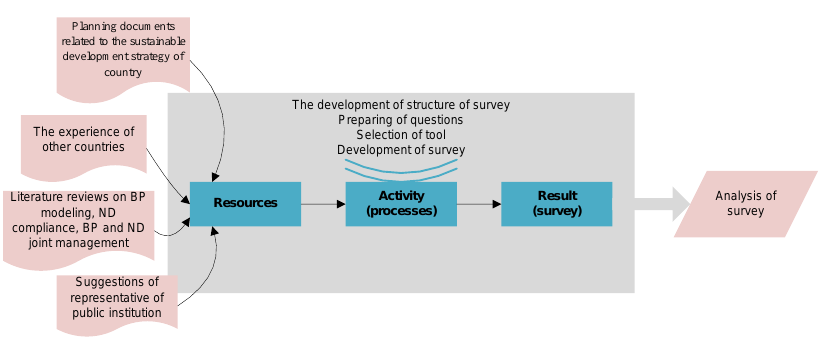
Fig. 1. Research steps to the knowledge acquisition about the current state on BP and ND in public